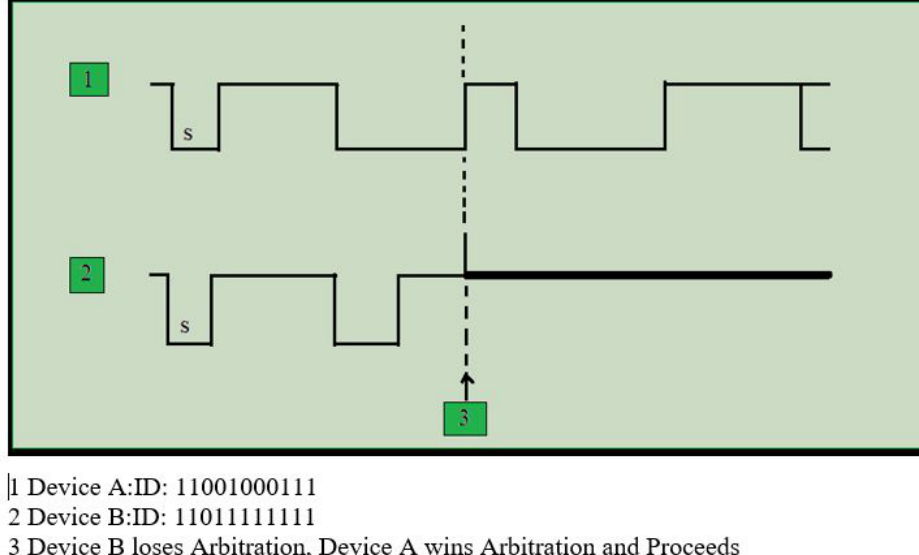
Figure 5. CAN contain built-in priority for messages to avoid